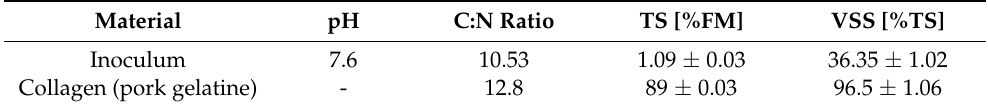
Table 1. Physicochemical characteristics of the inoculum and substrates used in various tests. Material pH C:N Ratio TS